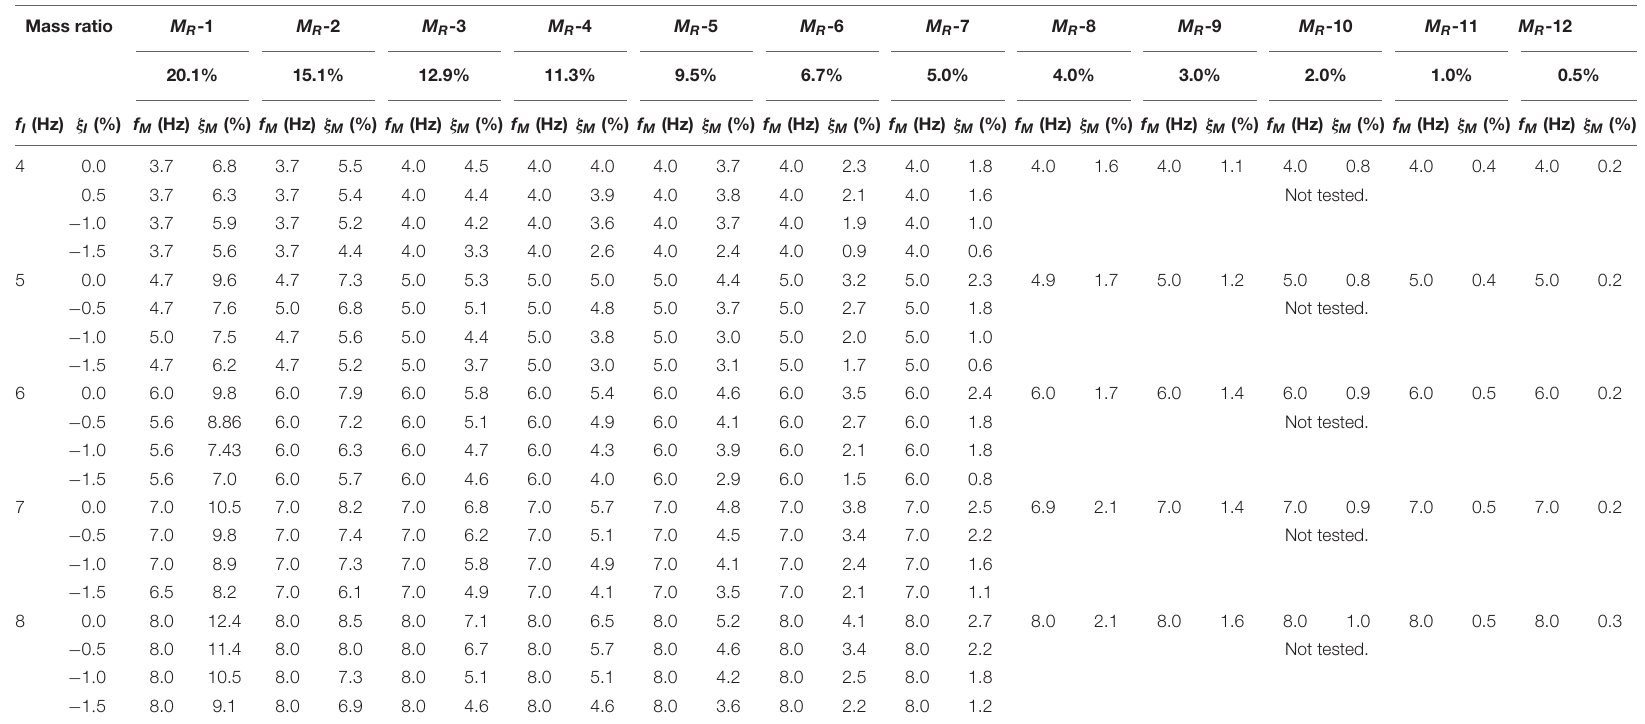
TABLE 2 | Free vibration